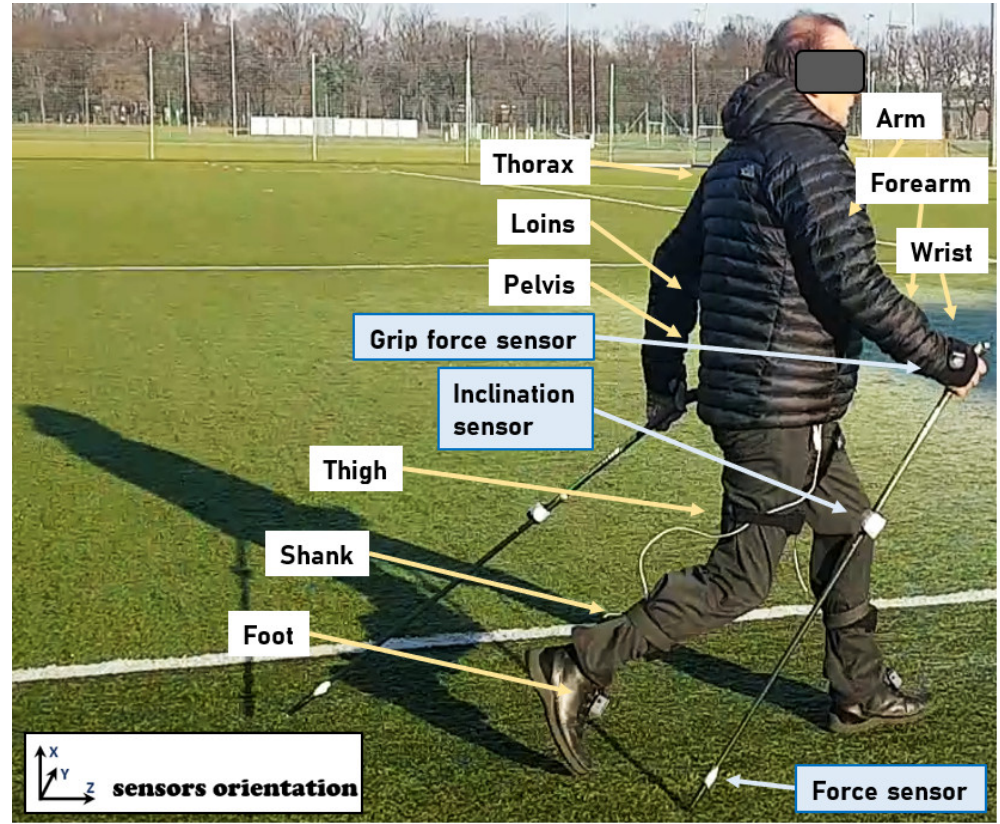
Figure 1. Illustration of sensors placement on the human body and the